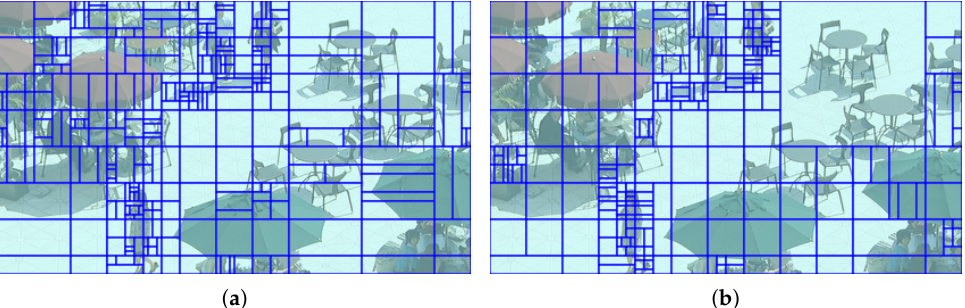
Figure 7. Illustration of the block partition structure of VTM-11.0 NNVC-1.0 anchor and the proposed ABPN-based bi-prediction. POC74 of BQSquare under LDB and QP27. ( a ) VTM-11.0 NNVC-1.0 anchor (5992 bits/Y PSNR 34.8423 dB). ( b ) ABPN-based bi-prediction (4848 bits/Y PSNR 34.8509